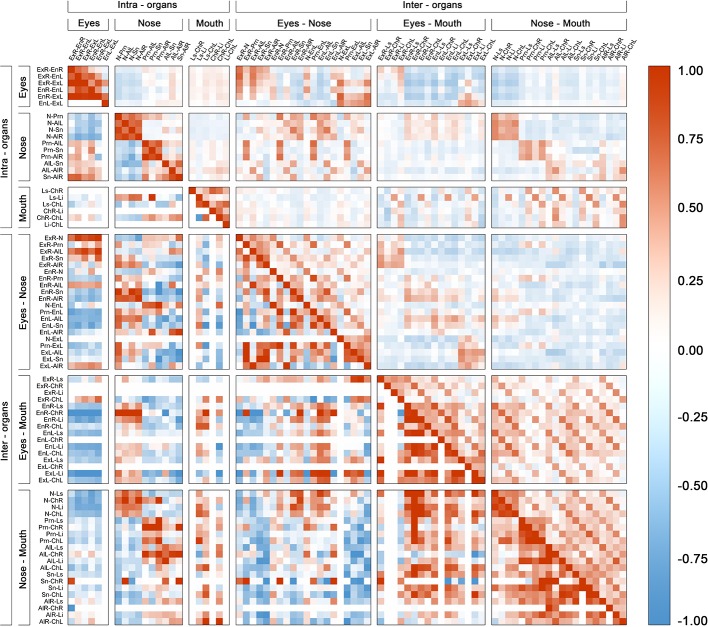
Phenotypic and genetic correlation matrix between all facial phenotypes in cohort RS.Positive correlations are shown as brown squares; Negative correlations are shown as blue squares. Phenotypic correlation is shown above the diagonal and SNP-based genetic correlation is shown below the diagonal. The matrix was organized according to the involvement of intra- and inter- organ landmarks.